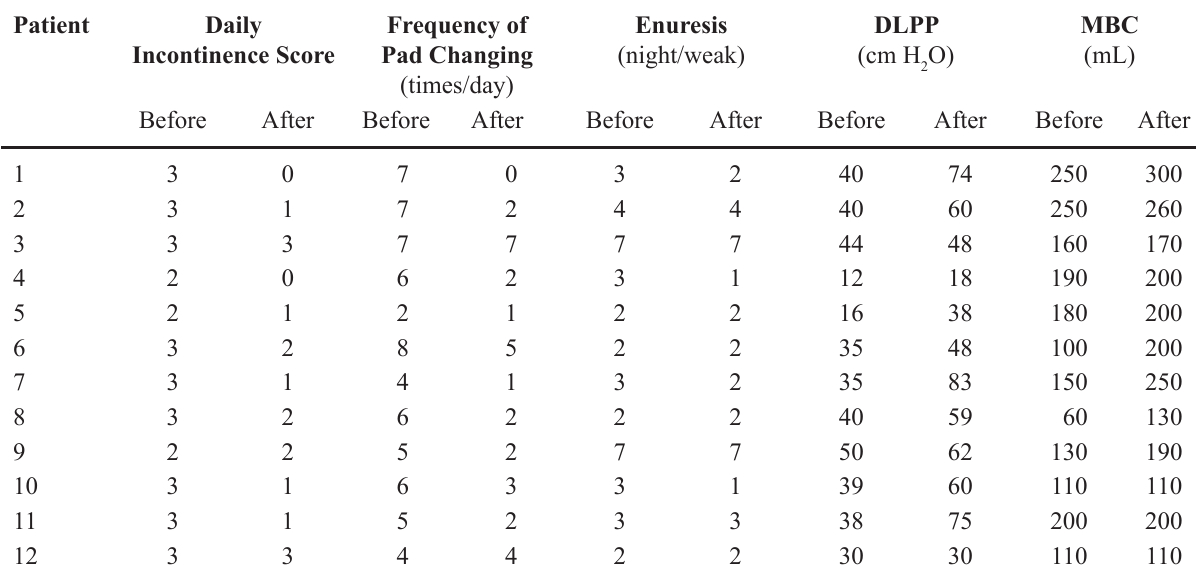
DLPP = detrusor leak point pressure; FES = functional electrical stimulation; MBC = maximal bladder